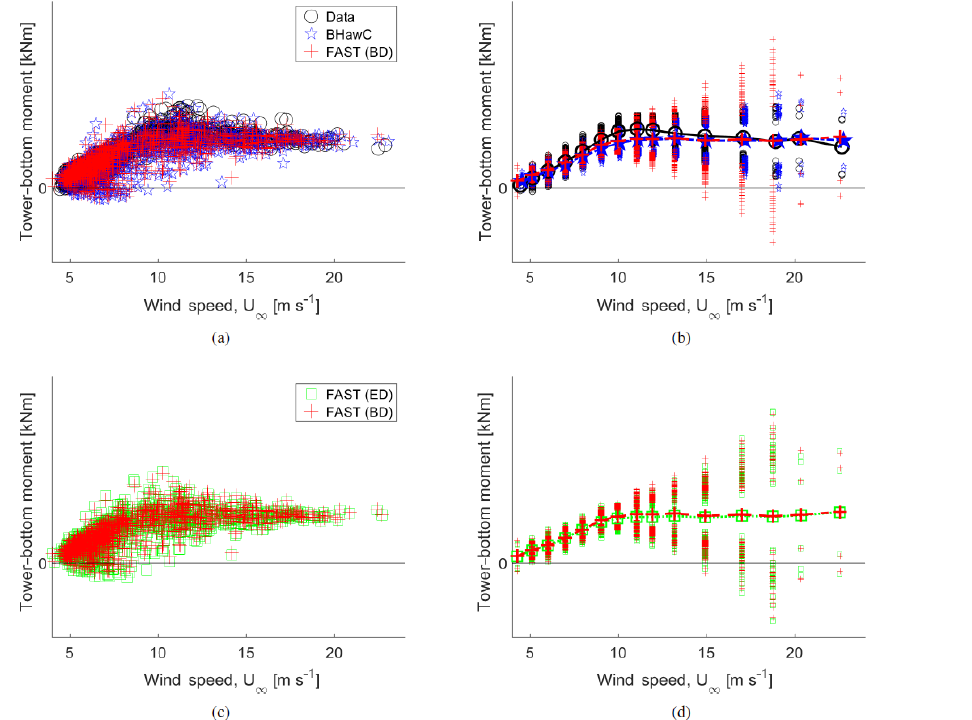
Figure 10. Tower-bottom side–side bending moments. (a) Individual 10min averages from experimental data, BHawC, and FAST (BD). (b) Binned averages of data in (a) are denoted by points connected by lines; the scatter above and below these data denotes plus or minus 1 standard deviation, respectively, of the individual 10min data sets in that bin. (c) Individual 10min averages from FAST (BD) and FAST (ED). (d) Binned averages of data in (c) are denoted by the points connected by lines; the scatter above and below these data denotes plus or minus 1 standard deviation, respectively, of the individual 10 min data sets in that